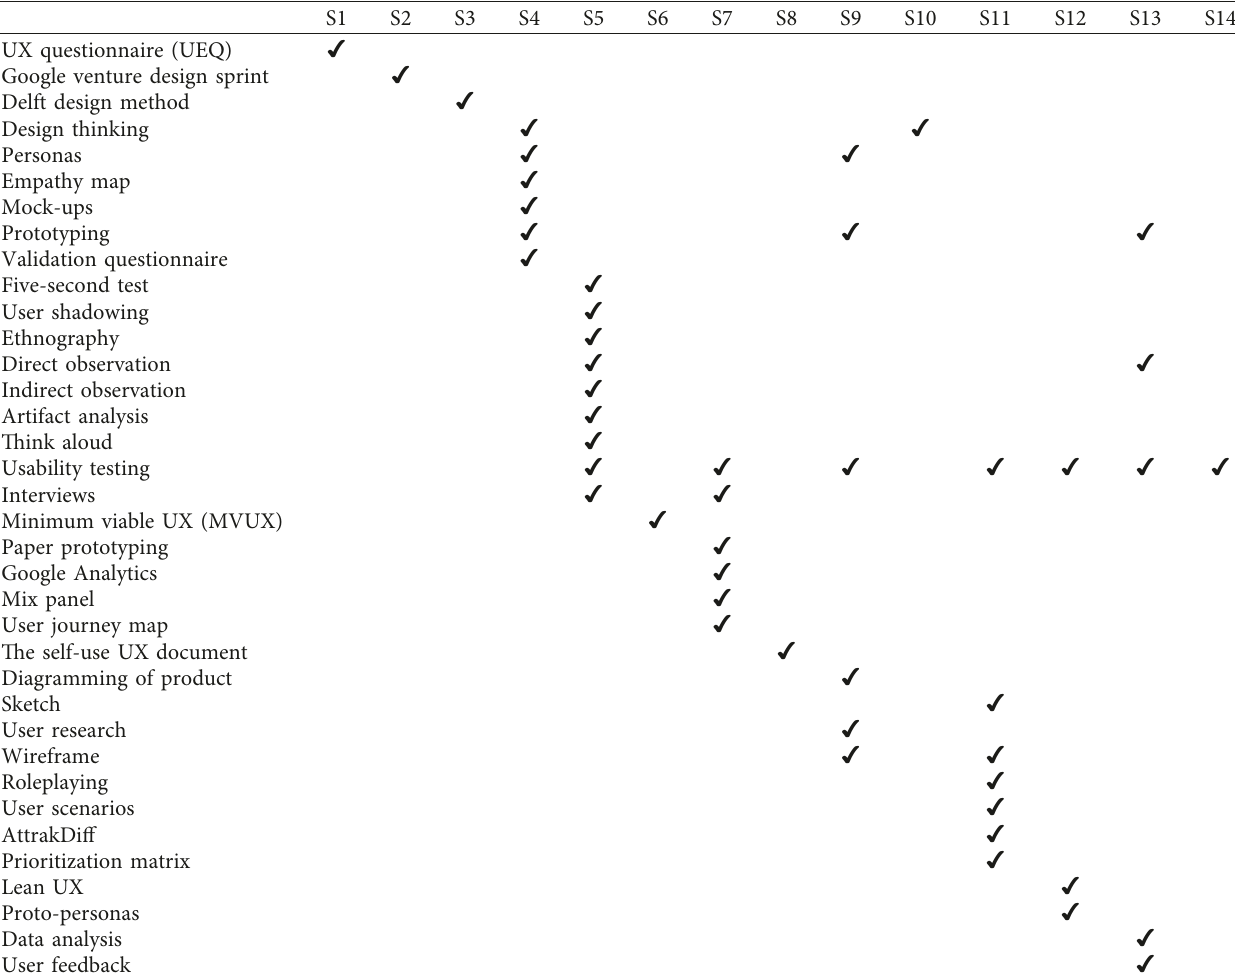
Table 5: Methods, practices, and tools of UX used in startups